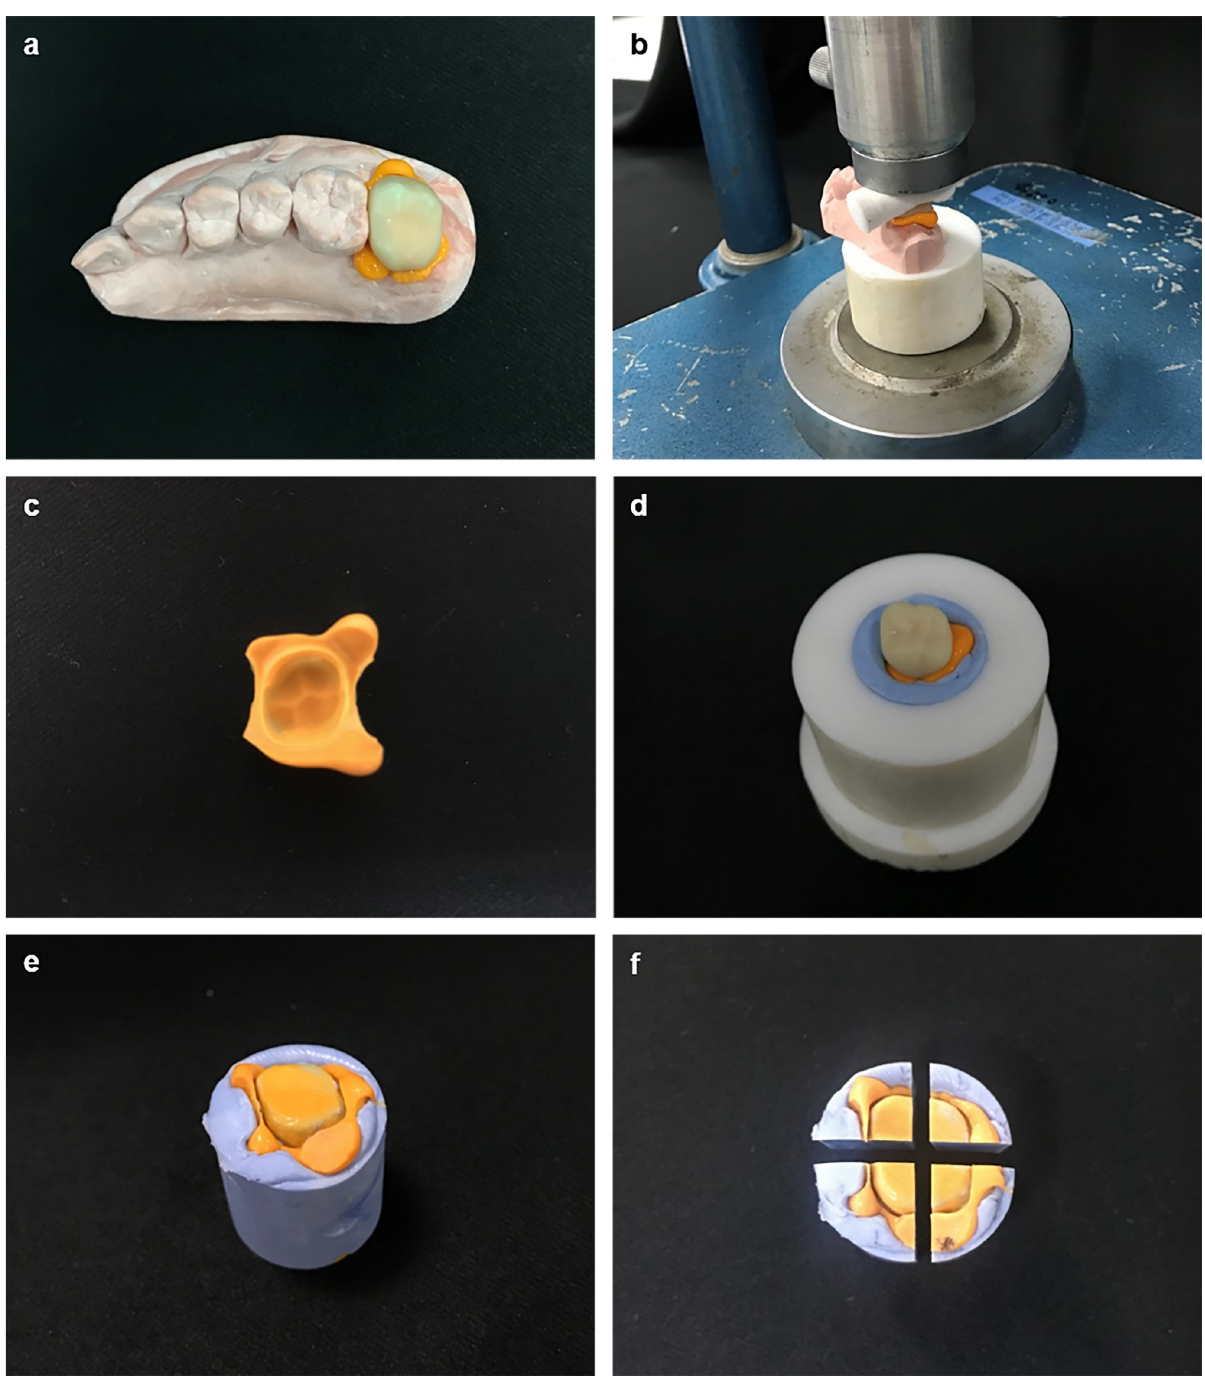
Fig 10. Two-dimensional replica method. (a) Filled with light-body impression materials and seated together with the stone models, (b) 50 N of pressure was applied for 5 minutes using static load equipment, (c) the pressure was removed from the stone models after polymerization, (d) cylinder- shaped molds were filled with putty, (e) the specimen was created, (f) the specimen was sectioned buccolingually and mesiodistally at the midline.